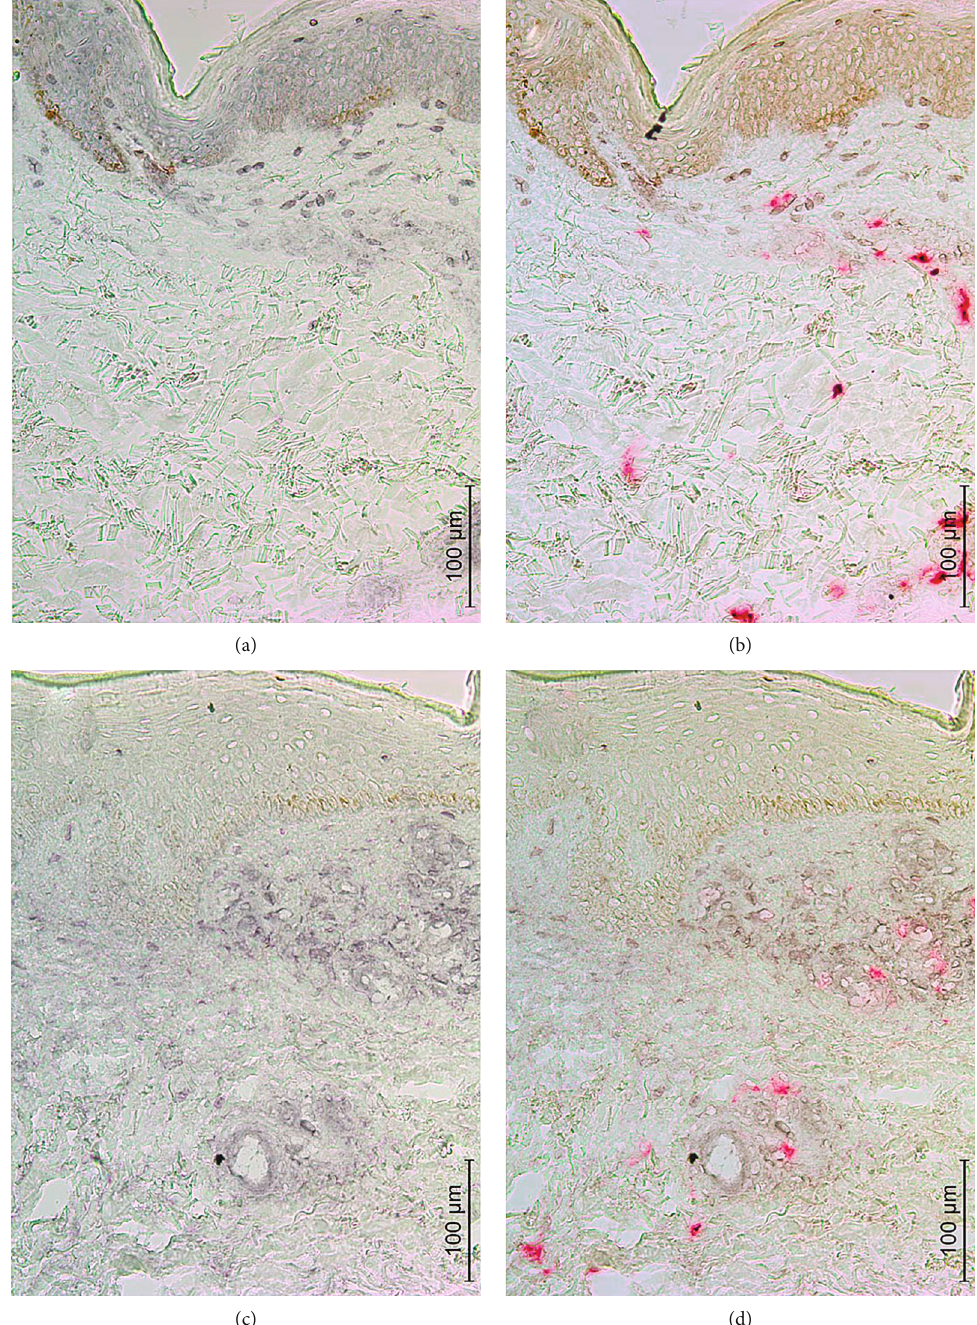
Figure 3: A sequential immunohistochemical staining of fi rst complement factor I (a, c) and then mast cell tryptase (b, d). The skin biopsies were from the nonlesional skin (a, b) and palpable purpura lesion (c, d) of a patient with vasculitis. The micrographs were taken using a 20x objective (scale bar 100 μ